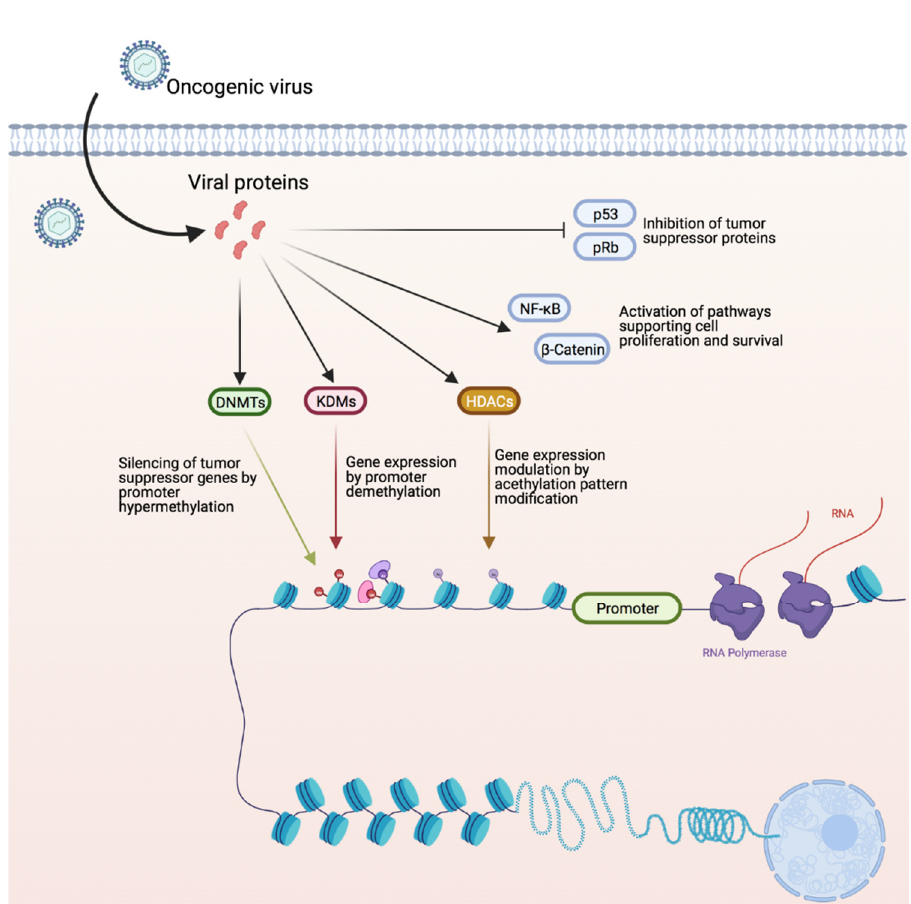
Figure 6. Common epigenetic alterations caused by oncogenic viruses. The host’s gene expression manipulated by interaction of the viral proteins with methyltransferases, demethylases and histone acetyl transferases. In general, these interactions result in silencing of tumor suppressor genes by hypermethylation of their promoters. At the same time, demethylases and acetyl transferases are targeted to specific loci to modulate their transcription. Viral proteins can also physically interact with the host tumor suppressor proteins inducing their degradation or preventing their interaction with target proteins. Similar mechanisms are employed to activate pathways to support proliferation or promote cell survival. Credits: Created with BioRender.com.